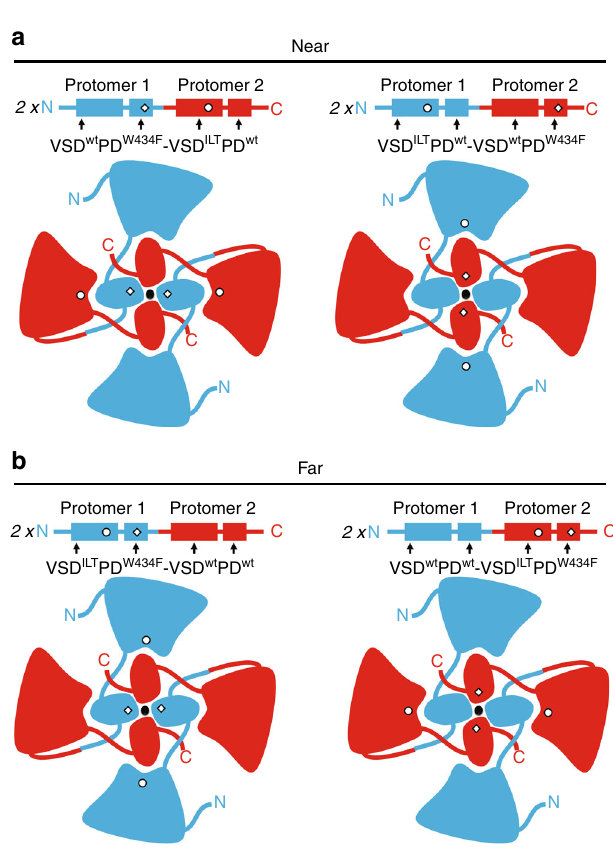
Fig. 2 Schematic representation of near and far con fi guration Shaker dimers. a Near con fi guration dimers shown in two possible designs, both with VSD ILT and PD W434F in different protomers (VSD wt PD W434F - VSD ILT PD wt or VSD ILT PD wt -VSD wt PD W434F ). Protomer 1 is shown in blue and protomer 2 is shown in red in the top left and right panels with the mutant VSD indicated by circles and mutant PD indicated by